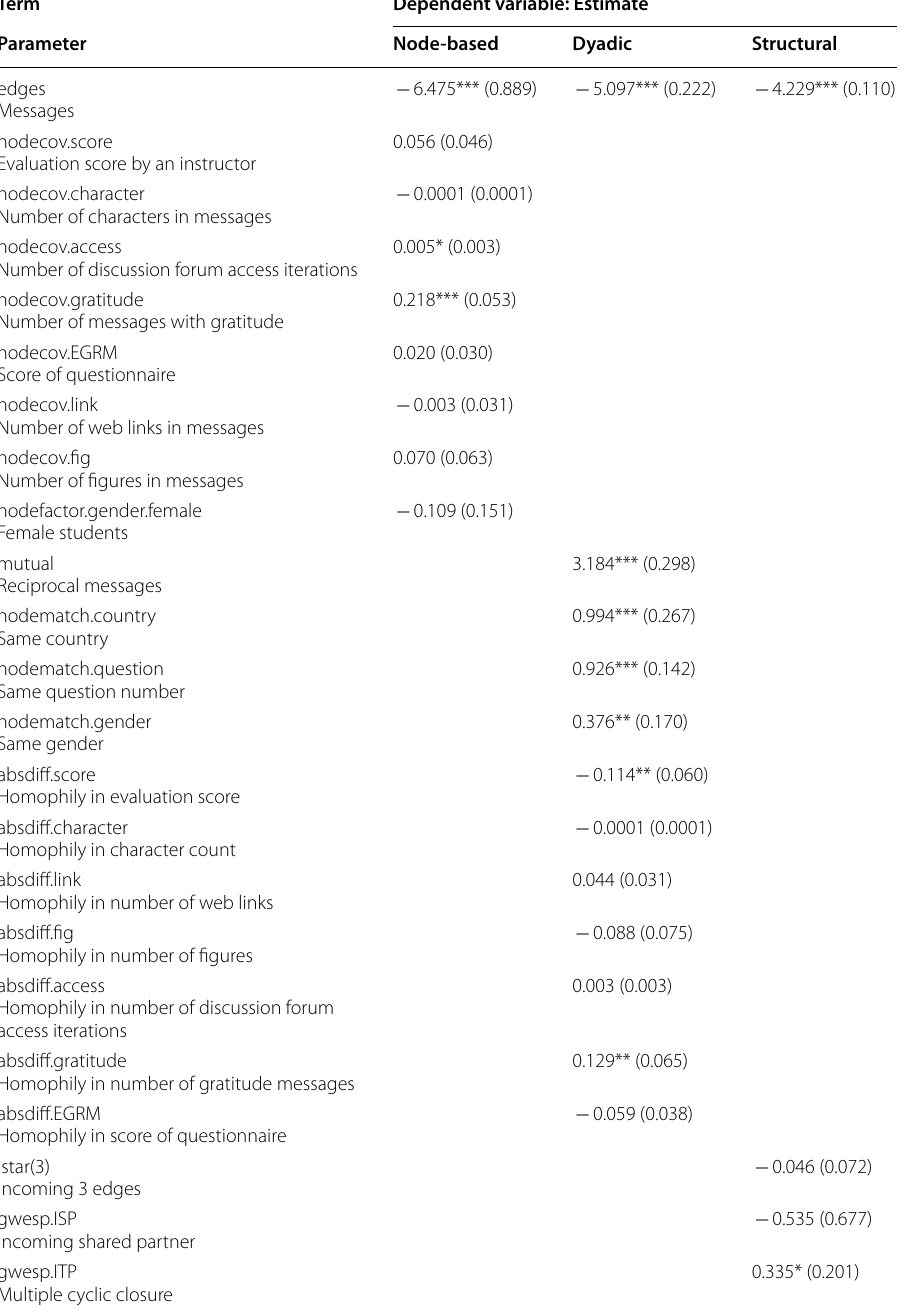
Table 2 Results of maximum likelihood estimation on ERGM